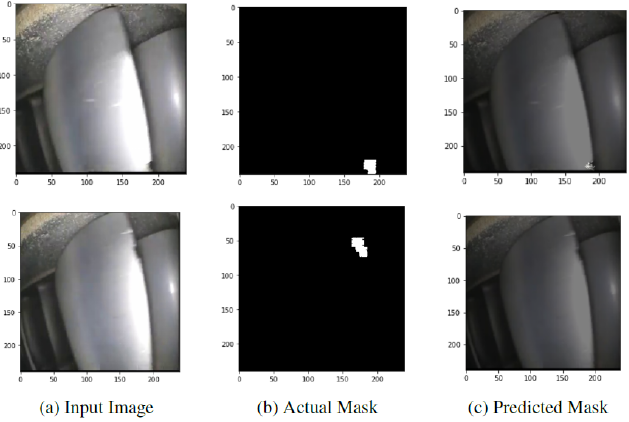
Figure A3. FL segmentation on test data after 50 epochs.